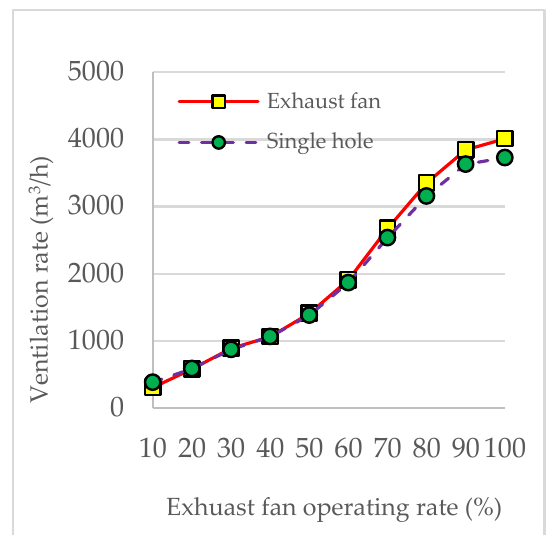
Figure 3. Enclosing ability of metallic cover.